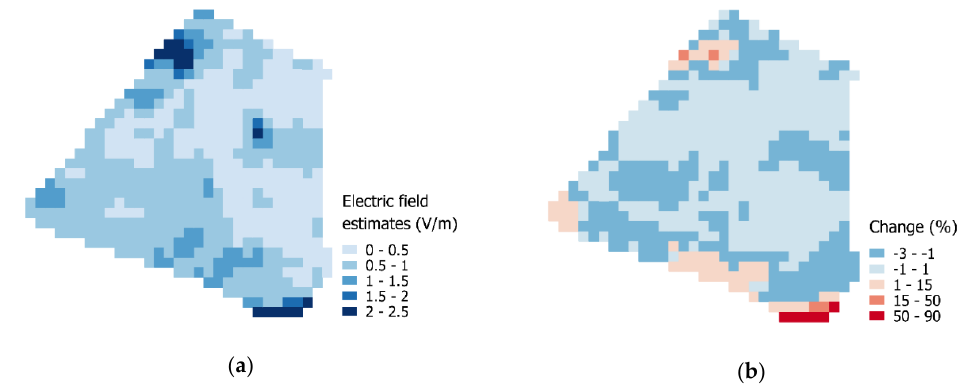
Figure 3. Outdoor exposure estimates: ( a ) electric-field estimates from ordinary kriging (V / m); ( b ) percentage change in median exposure after taking time profiles into account.